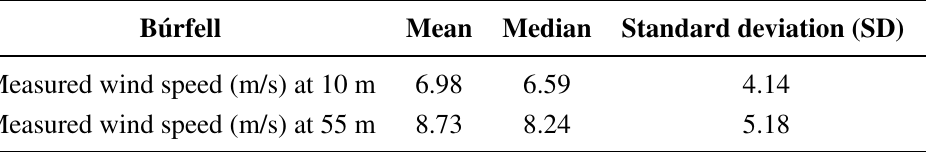
Table 1. Measured wind speed data at